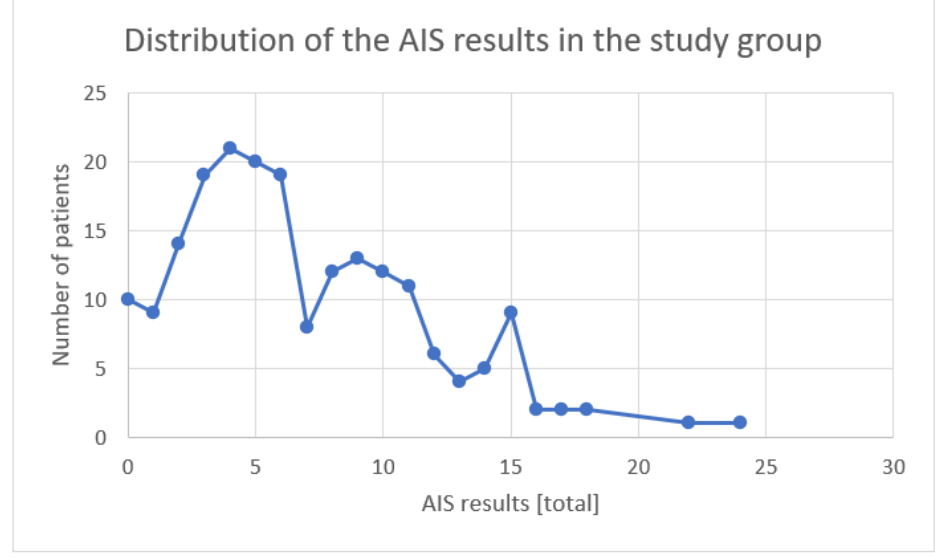
Figure 1. Distribution of the AIS results in the study group.